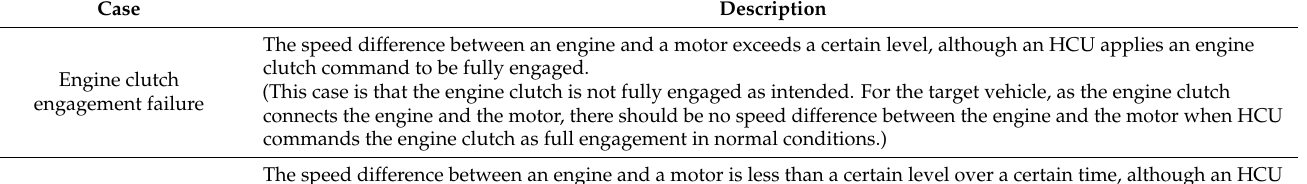
Table 1. Representative anomalous behaviors in engine clutch engagement/disengagement.